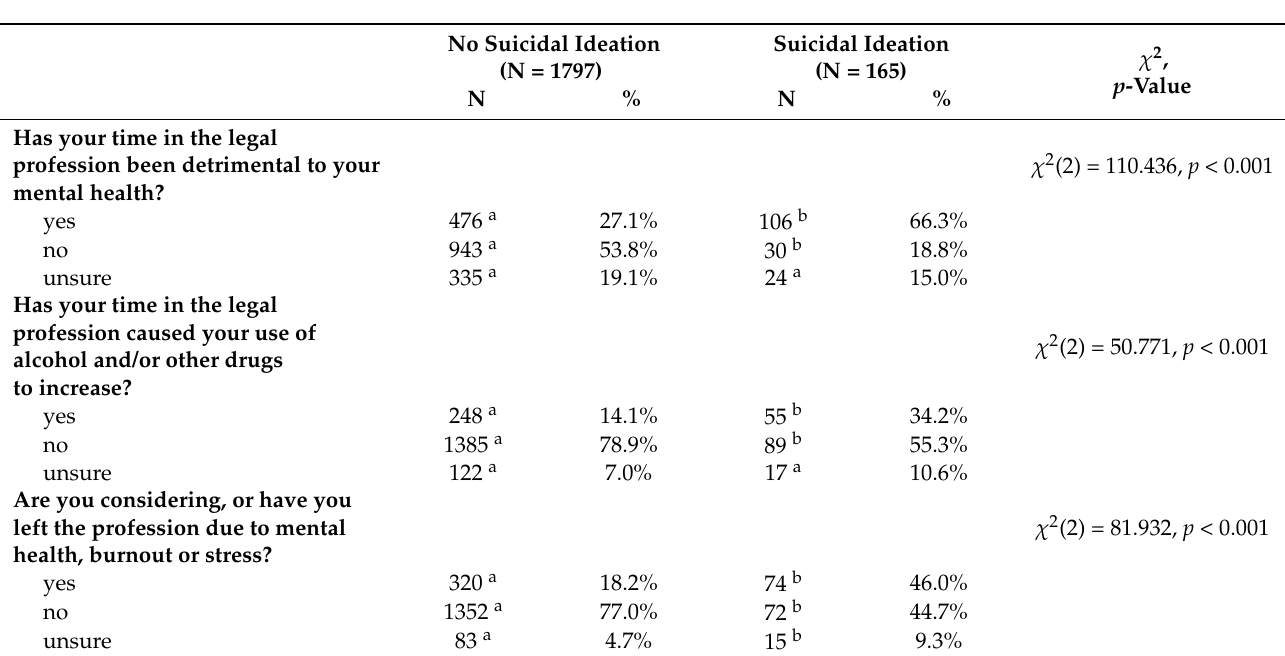
Table 4. Proportion of participants with and without PHQ-9 suicidal ideation with responses to